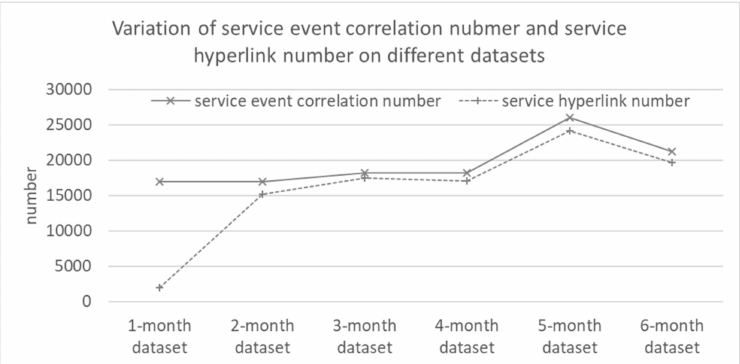
Figure 7. Variation of correlation number and hyperlink number on different datasets with p ≥